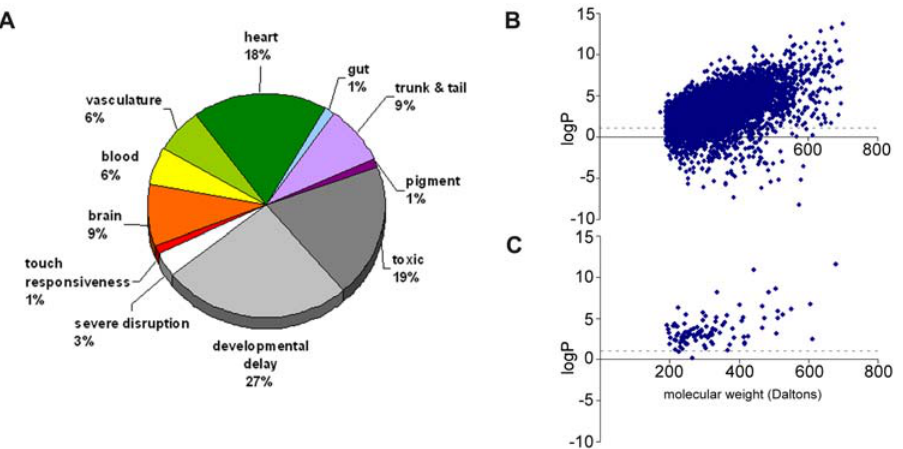
Figure 1. Zebrafish small-molecule screen identifies compounds that effect development. a) 4% of the 5760 compounds screened affected zebrafish embryos. 19% of the active compounds caused lethality. 175 compounds with detectable effects on zebrafish development were identified. b–c) The small molecules used for screening had molecular weights ranging from approx. 200 daltons to 700 daltons and had log P (partition coefficient) values ranging from 2 10 to + 15. However, the log P of the bioactive compounds were restricted to 0 to + 12. b) log P values between octanol and water of all the compounds screened plotted against their molecular weights. c) log P values of all the bioactive compounds (excluding the toxic compounds) plotted against their molecular weights.